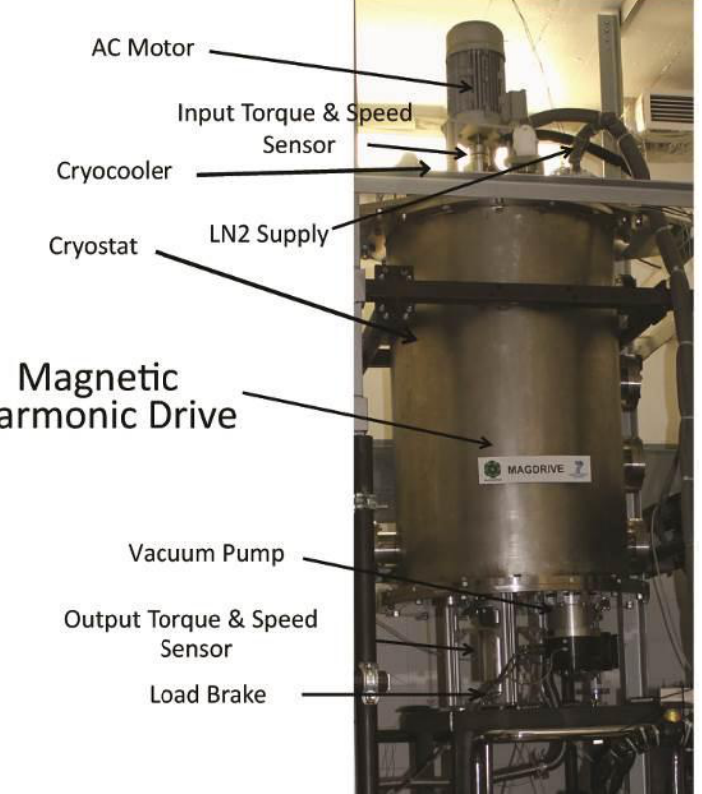
Figure 7. Thermal-vacuum chamber and external test rig